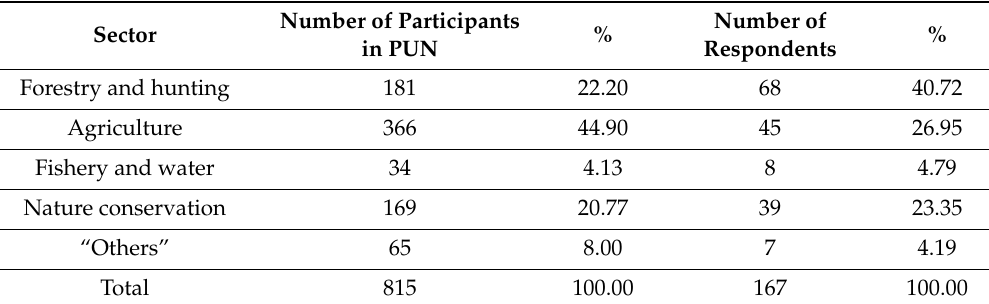
Table 1. Division of stakeholders by